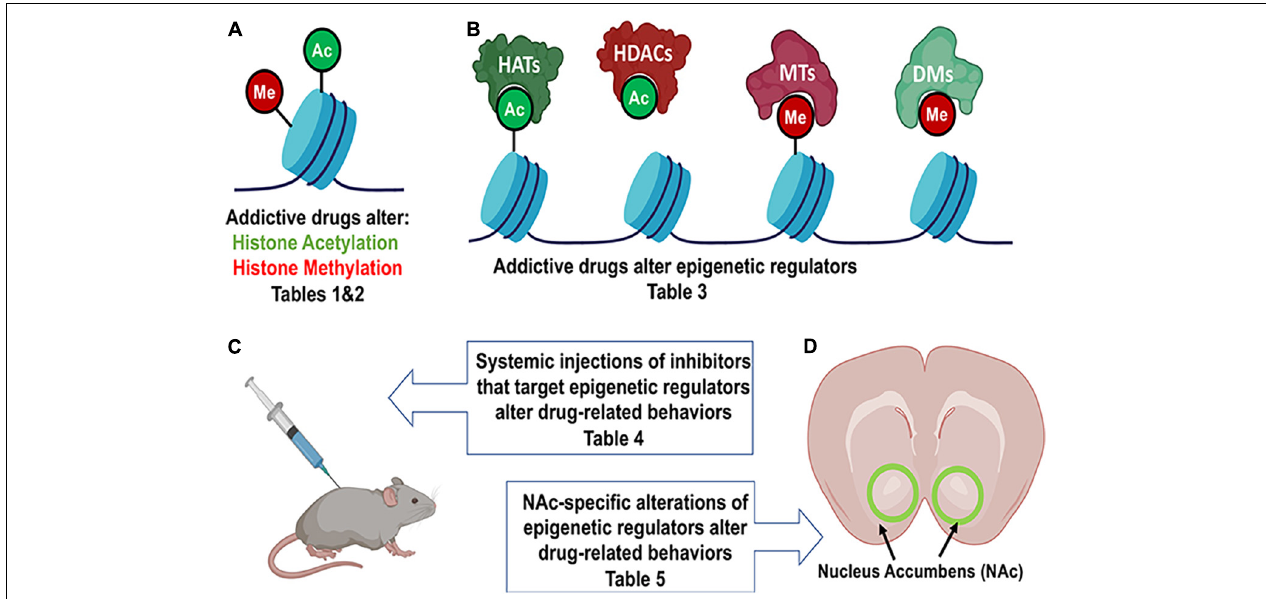
FIGURE 1 | Drug exposure induces changes in epigenetic regulation in the nucleus accumbens and alters behavior. (A) Histone modifications are a form of epigenetic regulation that can alter DNA transcription. Two well studied modifications are acetylation (Ac) and methylation (Me). Increases in acetylation typically increase transcription and are thought to be “go” signals (green). In contrast, increases in methylation typically decrease transcription and are considered “stop” signals (red). Drug exposure has been shown to cause changes in histone acetylation ( Table 1 ) and histone methylation ( Table 2 ). (B) Histone acetylation levels of histones can be increased by histone acetyltransferases (HATs) and decreased by histone deacetylases (HDACs). Histone methylation levels can be increased by methyltransferases (MTs) and reduced by demethylases (DMs). Epigenetic proteins that modify histone acetylation and histone methylation are altered by drug exposure ( Table 3 ). (C) Altering the activity of epigenetic proteins via systemic injection of inhibitor or activator compounds can alter drug-related behaviors in rodent models ( Table 4 ). (D) Finally, accumbens-specific manipulations of epigenetic proteins can also alter drug-related behaviors ( Table 5 ). This figure was created in part with